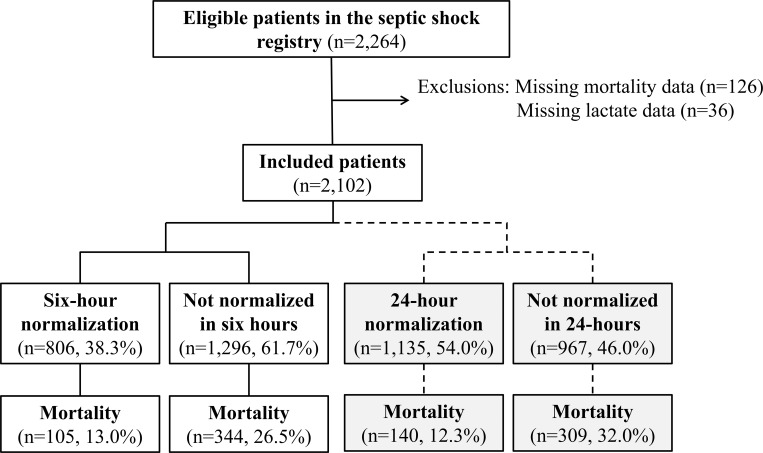
Diagram of the included patients.